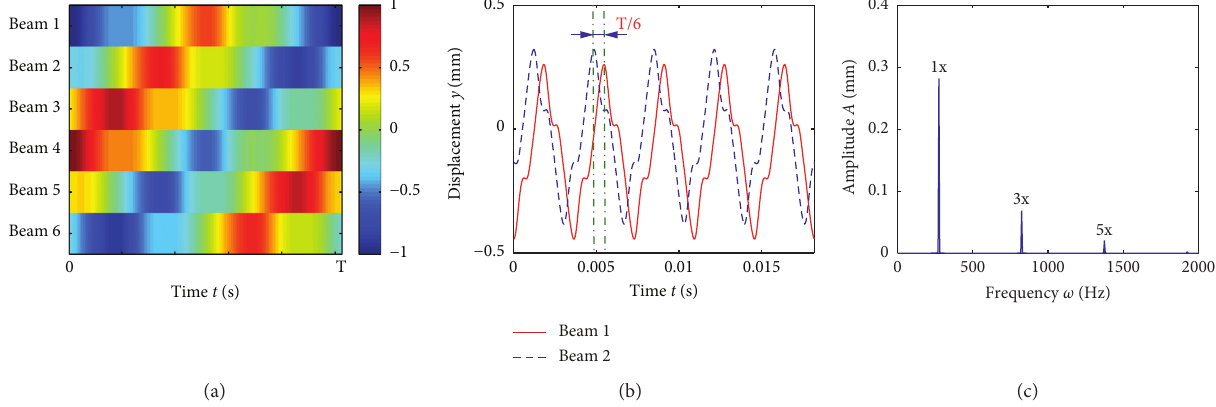
Figure 7: The response of beam root for Ω � 200rad/s: (a) response of beam 1 to beam 6, (b) response curve of beam 1 and 2, and (c) spectrum plot of beam 1.